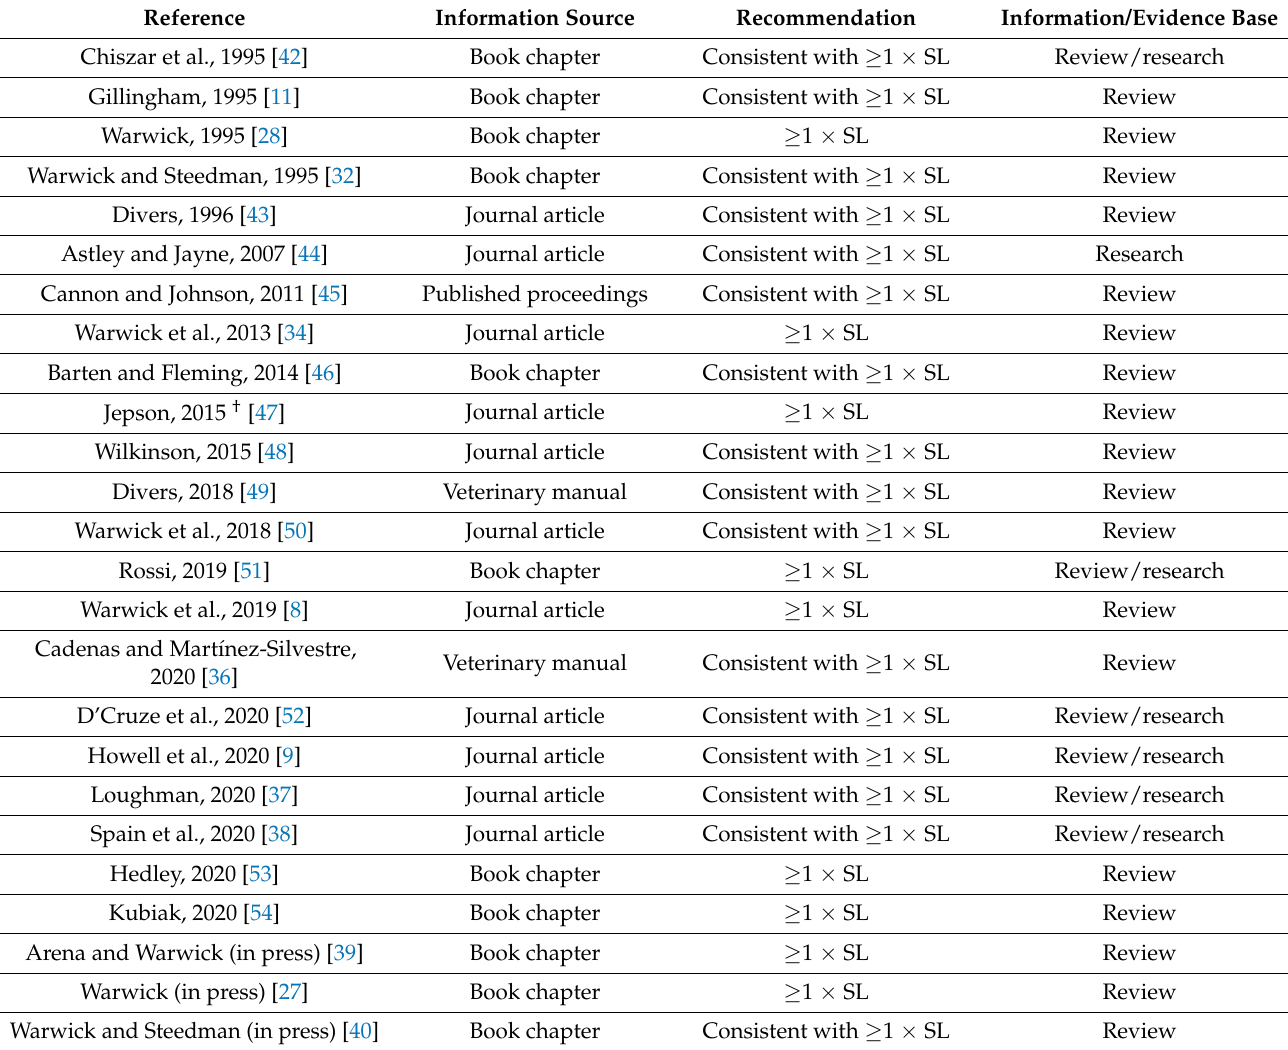
Table 3. Summary of findings for peer-reviewed * information sources and recommendations consistent with or specifying ≥ 1 × snake length (SL) minimum enclosure